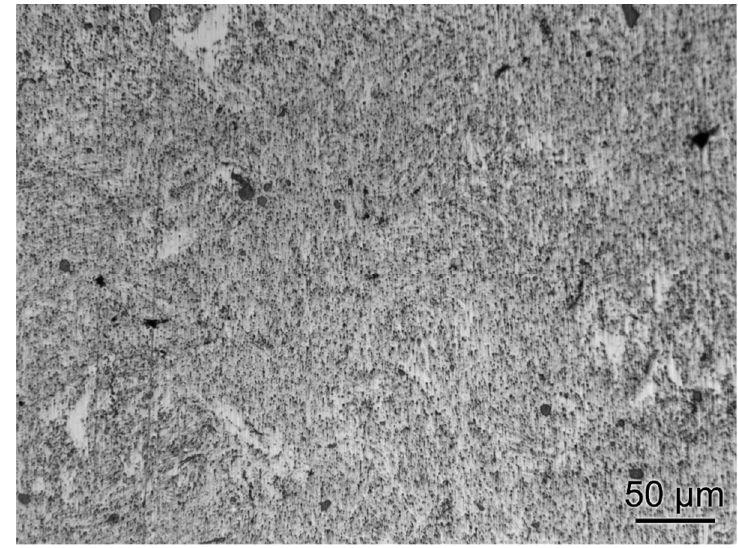
Figure 1. Low magnification optical micrograph of the nanocomposite pellets.